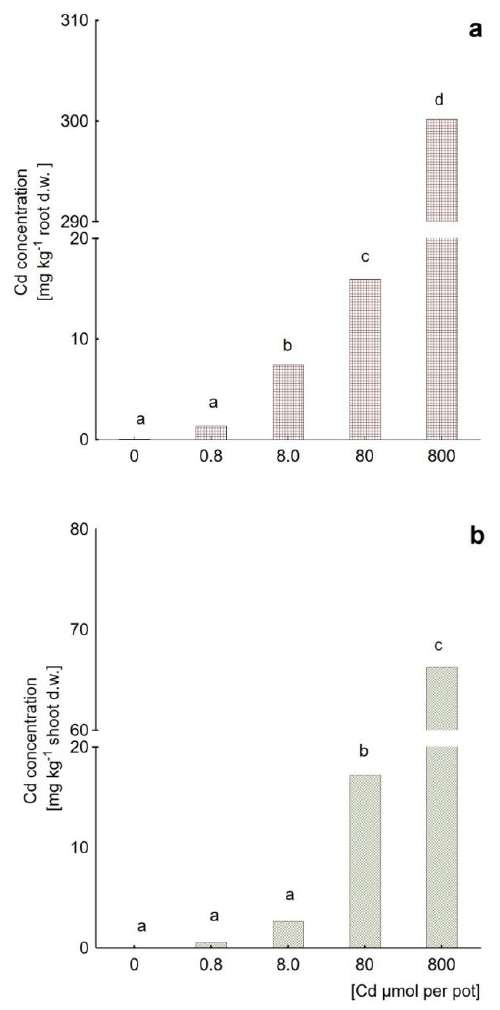
Figure 2. Cadmium content in ( a ) roots and ( b ) shoots of Mesembryanthemum crystallinum plants subjected to different Cd doses, ranging from 0.8 to 800 μmol of Cd applied per pot (untreated control at dose 0). Different letters above the bars indicate statistically significant differences at p ≤ 0.05.